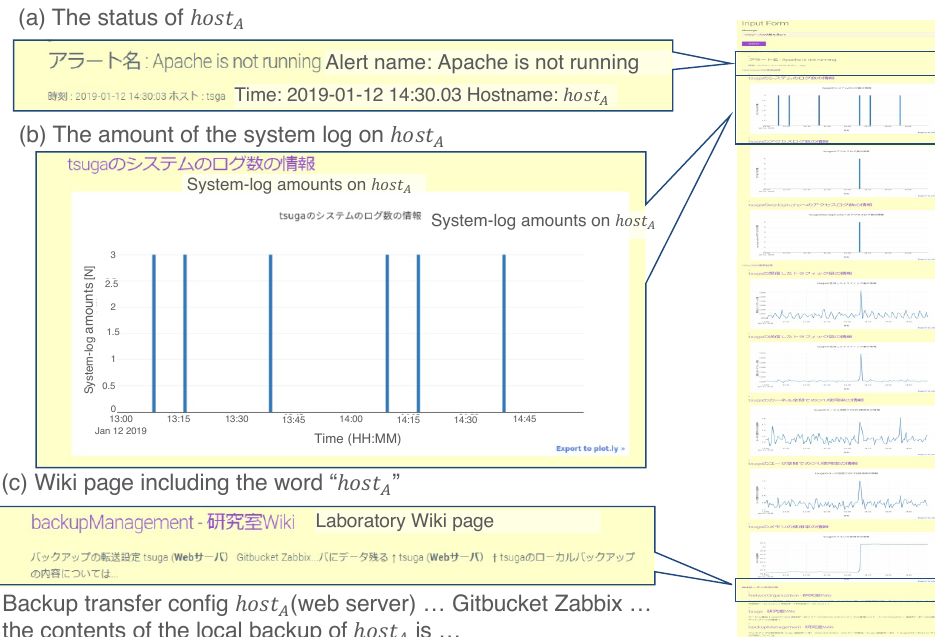
Figure 11. Example result for the prototype system in Case 1. We assert three remarkable re- sults: ( a ) status of host A , ( b ) amount of the system log on host A , and ( c ) wiki page including the word “ host A